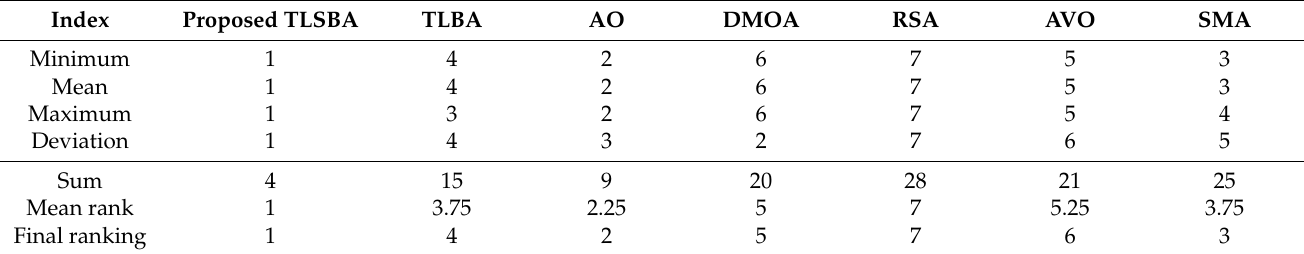
Table 7. Friedman ranking test of the compared algorithms for test system 3.